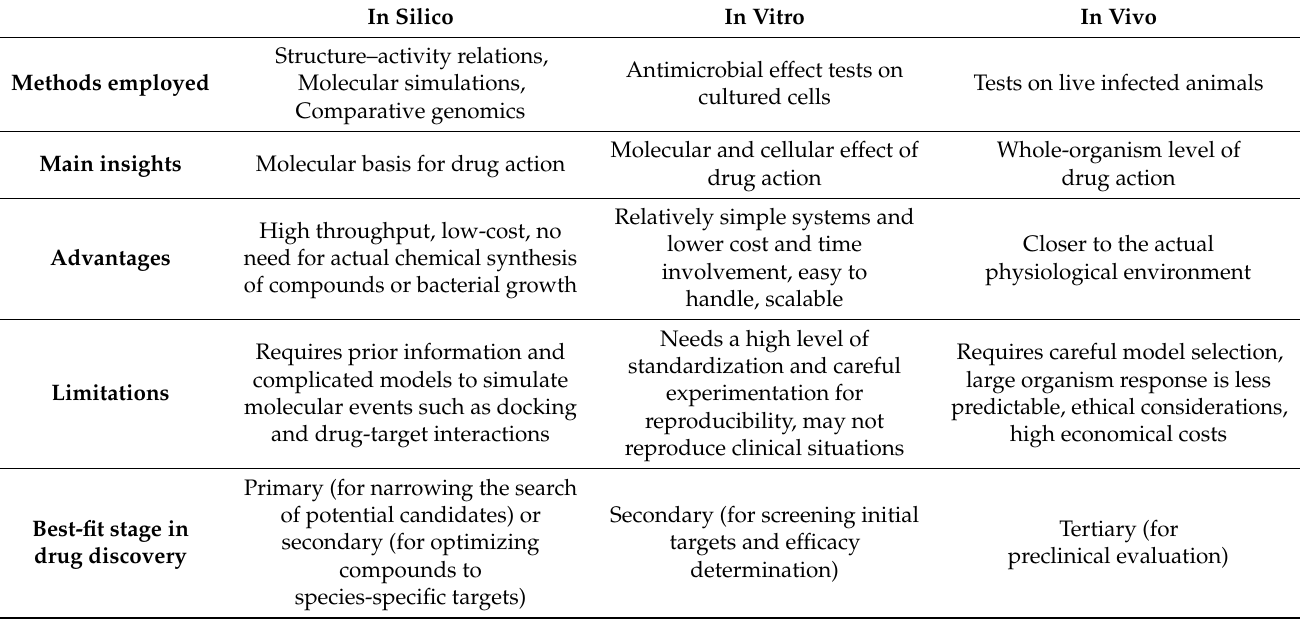
Table 2. Summary of the current methods available for the discovery of new antimicrobial therapies in